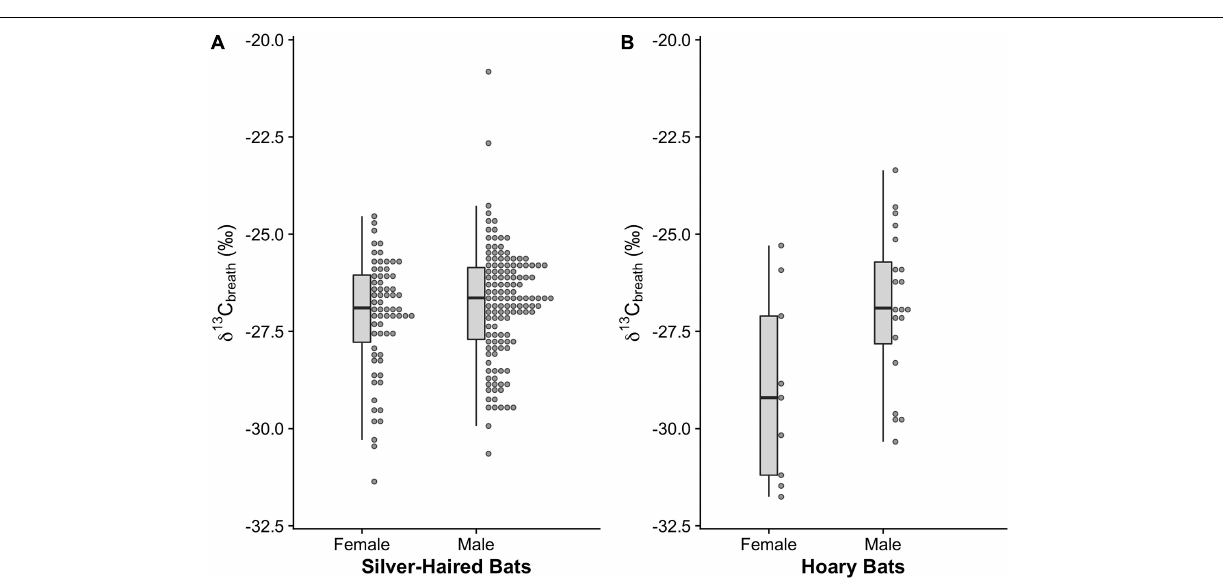
signature of − 26.79 ±